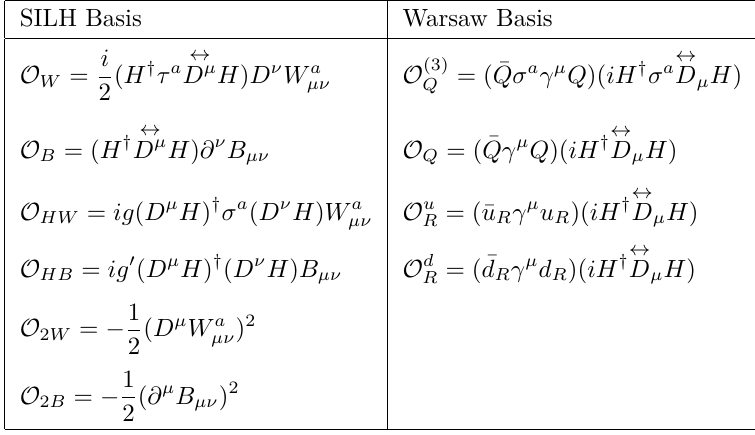
Table 1 . Dimension-six operators contributing to VBF Higgs production at high p h